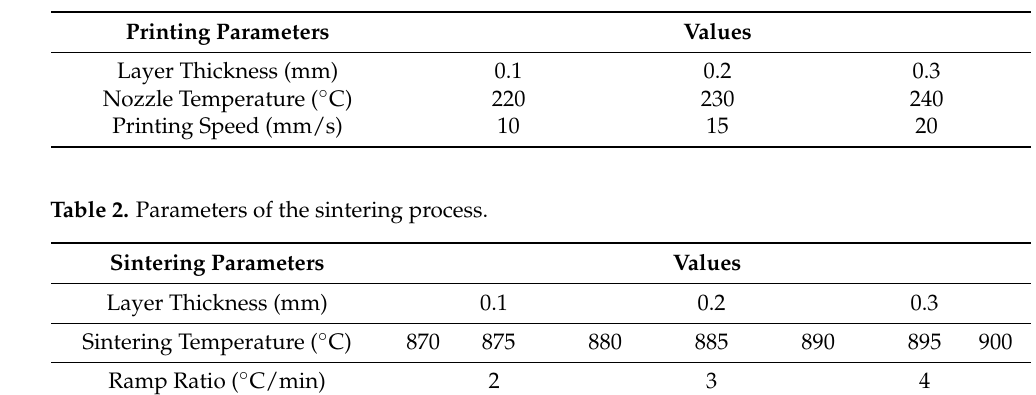
Table 1. Parameters of the printing process.